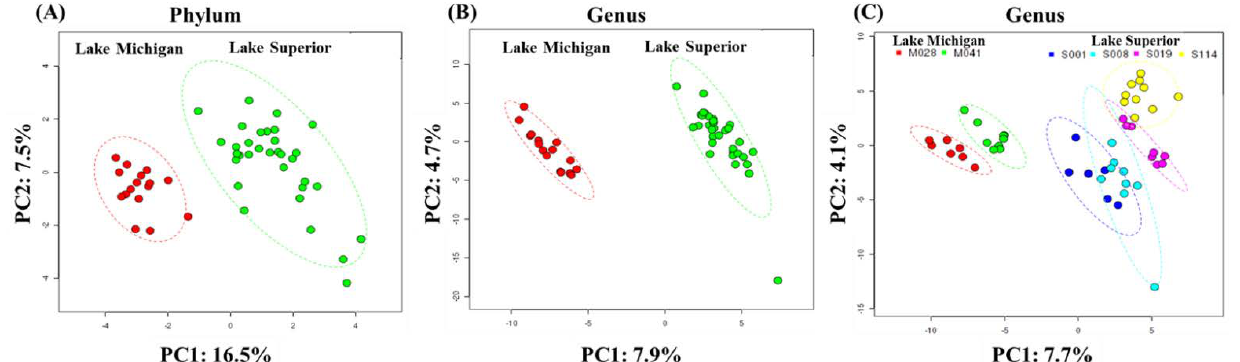
Figure 4. Principal coordinate analysis of the bacterial diversity at phylum level ( A ) and genus level ( B ) in Lakes Michigan and Superior. Also shown are ( C ) genus level diversity in different sampling locations in Lakes Michigan and Superior. Each dot in the graph represents a sample and color circles indicate various sampling locations. Red circles represent Lake Michigan and light green represent Lake Superior samples. The Lake Michigan and Lake Superior groups are well separated and could be differentiated readily using variation of the first two components (PC1 and PC2) of the PCA plot and noted in both axis labels. Similar direction and magnitude of clustering indicate a large positive association among the lake types. A 95% confidence interval was used as the threshold to identify potential outliers.